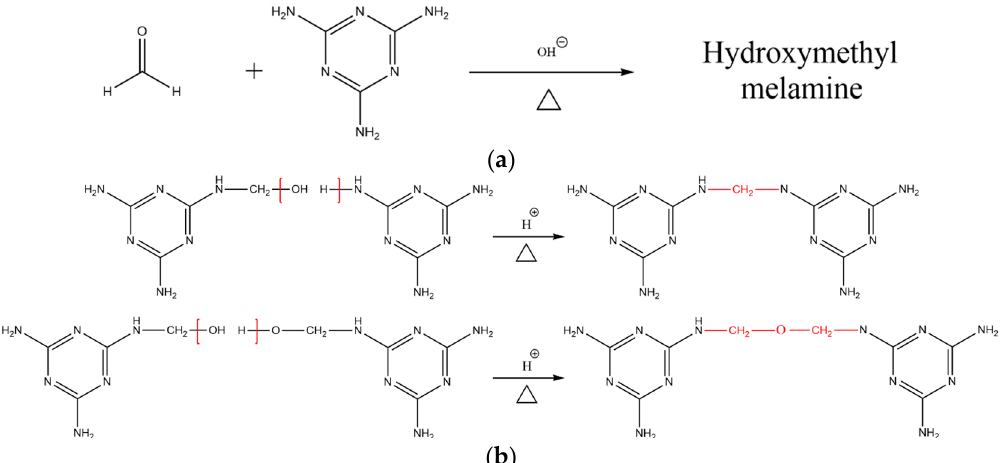
Figure 2. ( a ) Formation of MF prepolymer and ( b ) formation of MF resin.